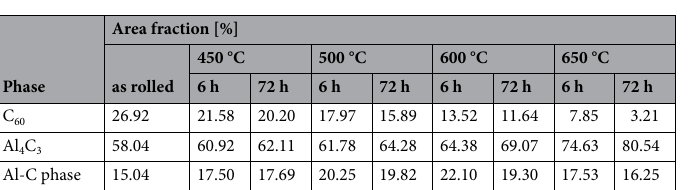
Table 1. Summary of area fraction of phases observed in Al/C